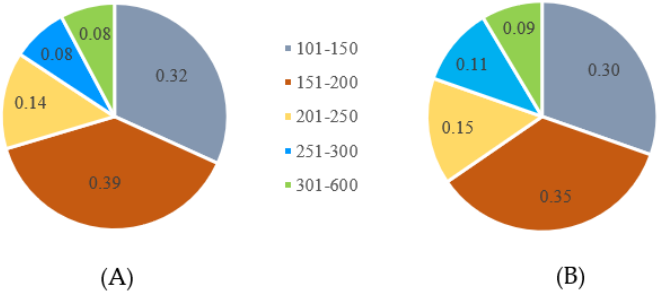
Figure 3. Sequence length distribution from the de novo assembly ( A ), number of sequences anno- tated with BLAST hits ( B ). Table 1. Pathway details of annotated SNP-associated contig s .